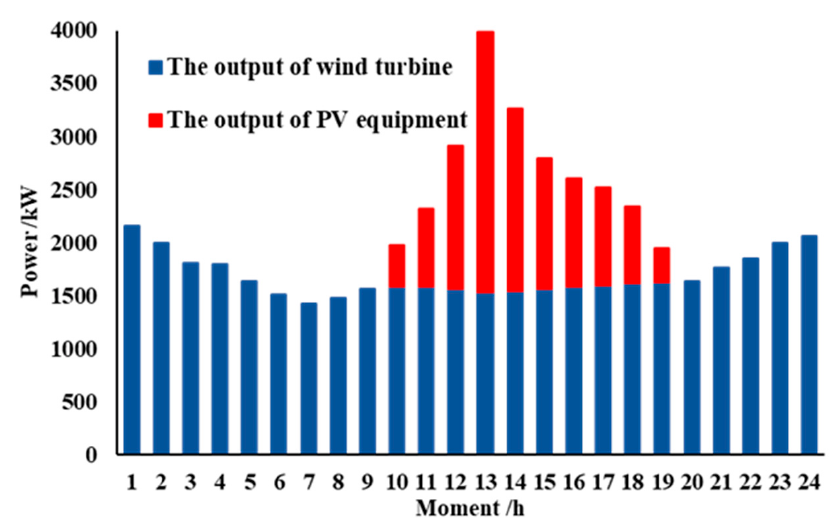
Figure A1. DG output variation during simulation day.